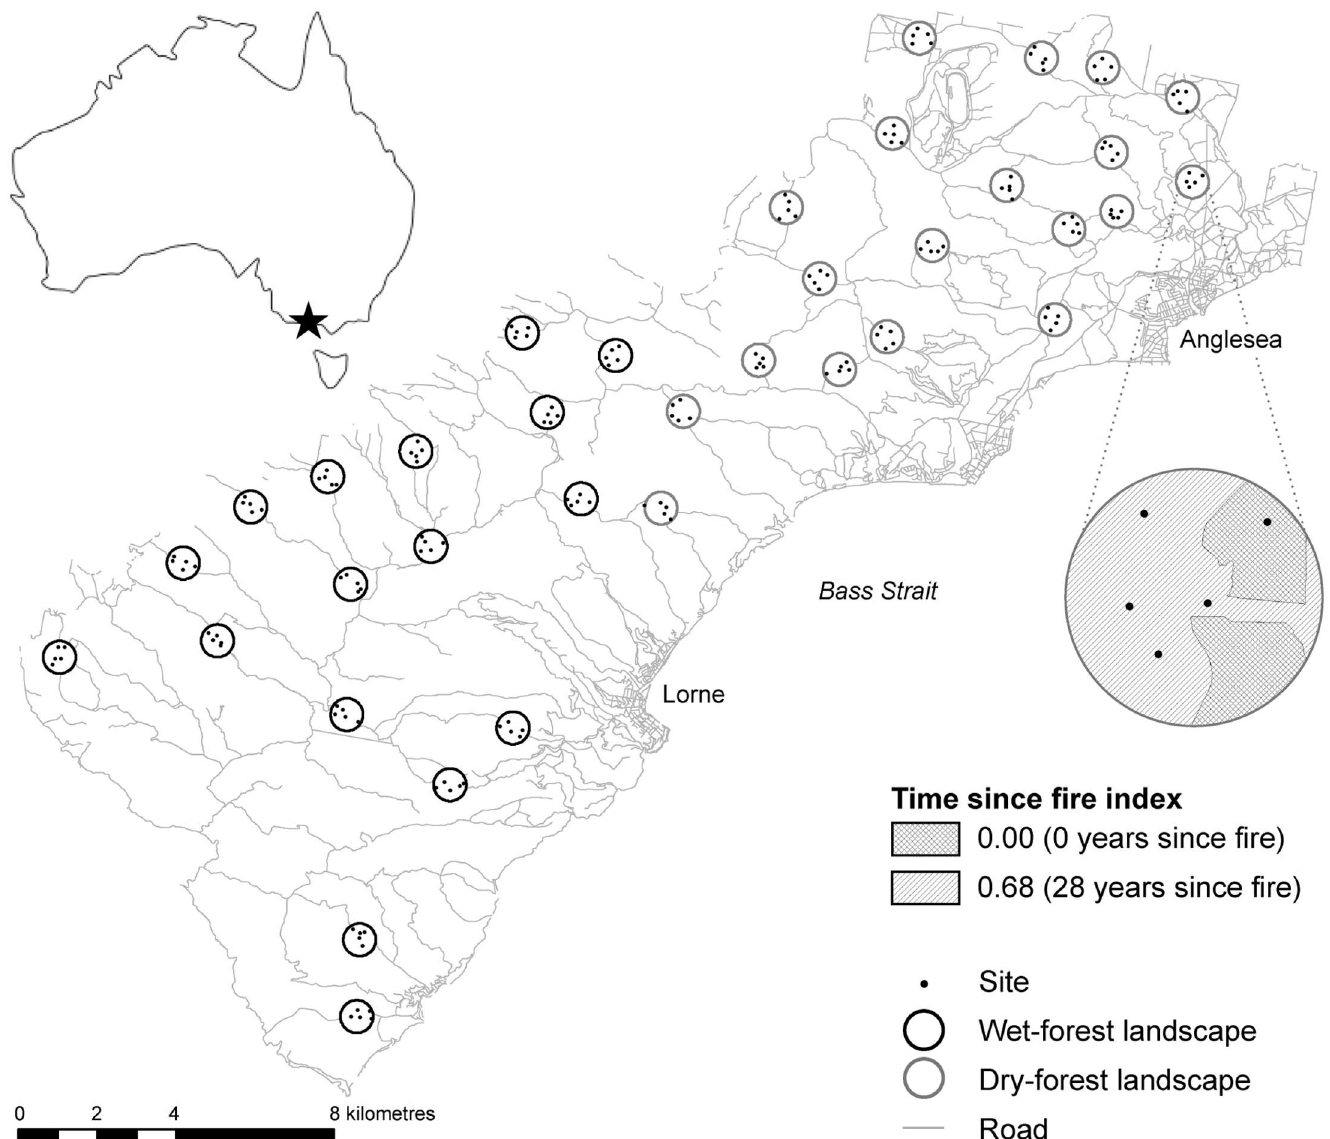
Fig 1. Location of the study area in southeast Australia. The enlargeddetail shows a single dry-forest landscape samplingunit of 100 ha (1.13 km diameter). Modified from Sitters et al. [52] under a CC BY license, with permission from Elsevier Ltd., originalcopyright